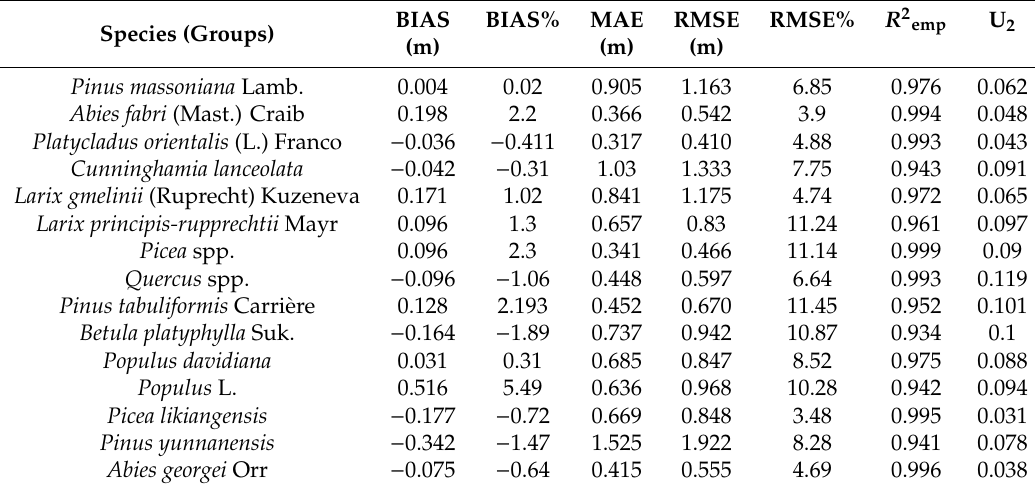
Table 5. Validation precision of tree height di ff erence equations for di ff erent tree species. Species (Groups)